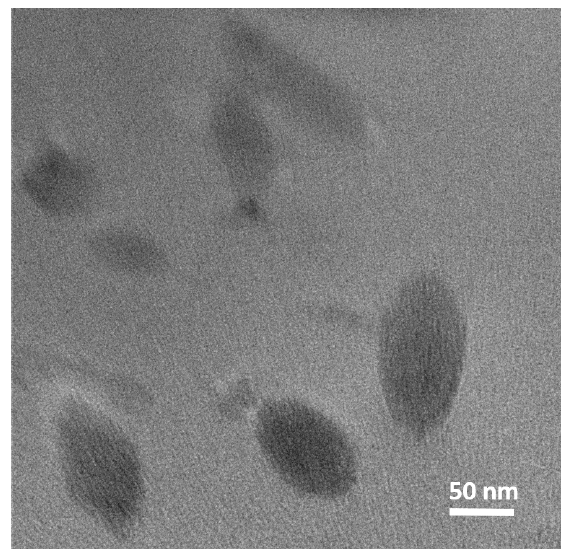
Figure 4. TEM image of the cross-section of the composite with 5 wt. % of MXene particles.